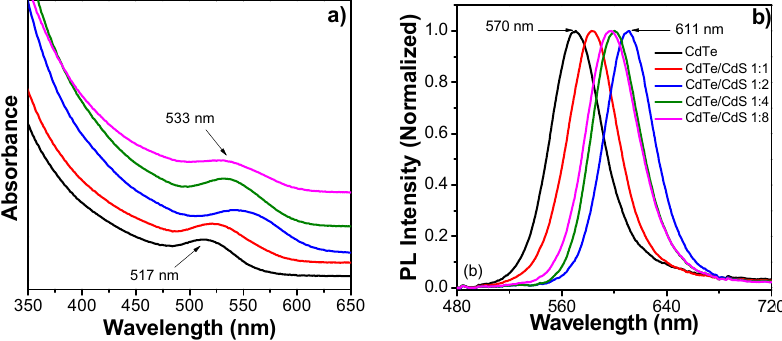
Figure 7. ( a ) UV–vis absorption, ( b ) PL spectra of the CdTe/MPA nanocrystals and the CdTe/CdS core/shell growth with Cd 2+ :thiourea (S 2 − ) molar ratios of 1:1, 1:2, 1:4, and